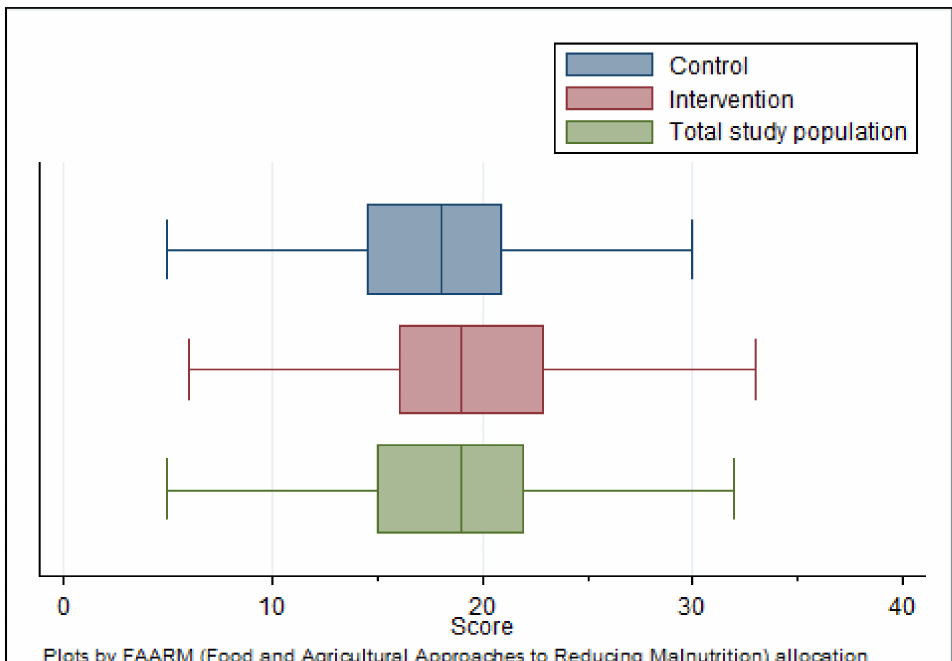
Figure 5. Distribution of overall knowledge score ( n =